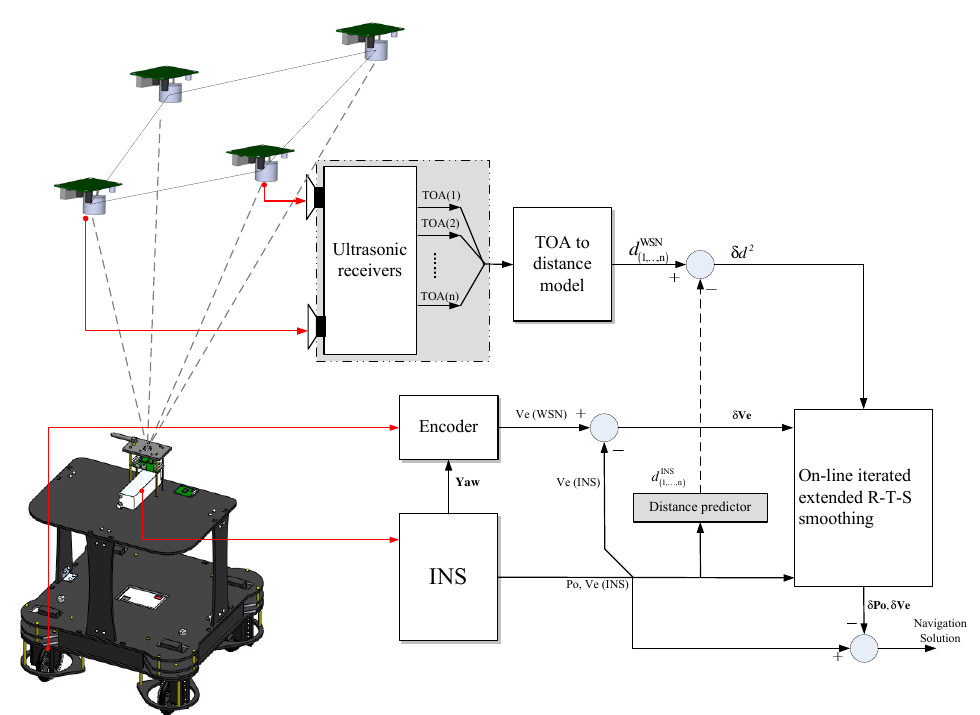
Figure 3. The robot is composed of an IMU, an ultrasonic sender and a wireless communication board. Its size is 380 mm × 380 mm × 400 mm (length × width × height). The performance characteristics of